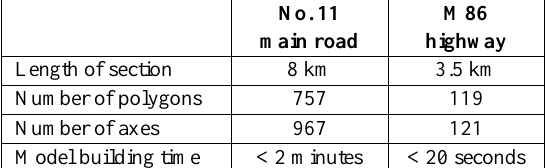
Table 1. Efficiency of the